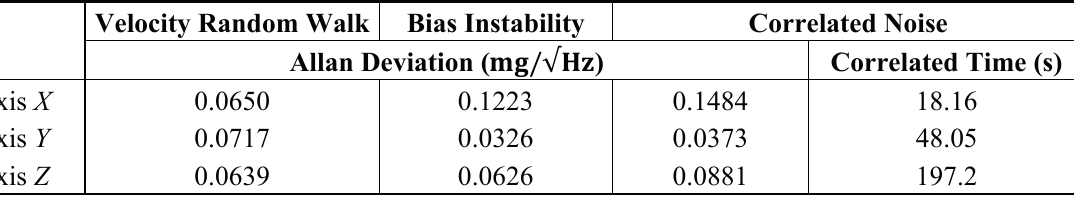
Table 1. Accelerometer noise